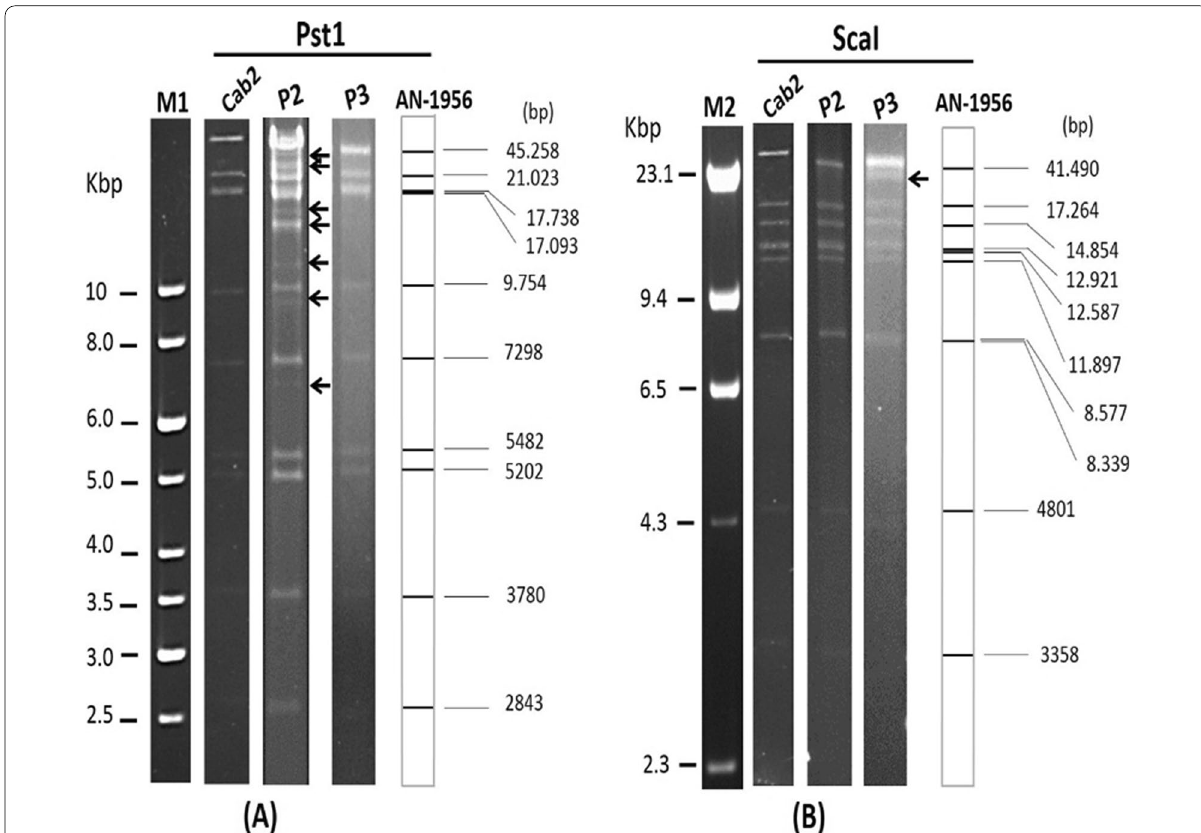
Fig. 1 Restriction endonuclease analysis of viral genomic DNA purified from Cab2, P2 and P3 isolates. A Restriction profile analysis of all isolates generated by Ps tI endonuclease. B Restriction profile analysis of all isolates generated by Sc aI endonuclease. Electrophoresis was generated on submolar bands among